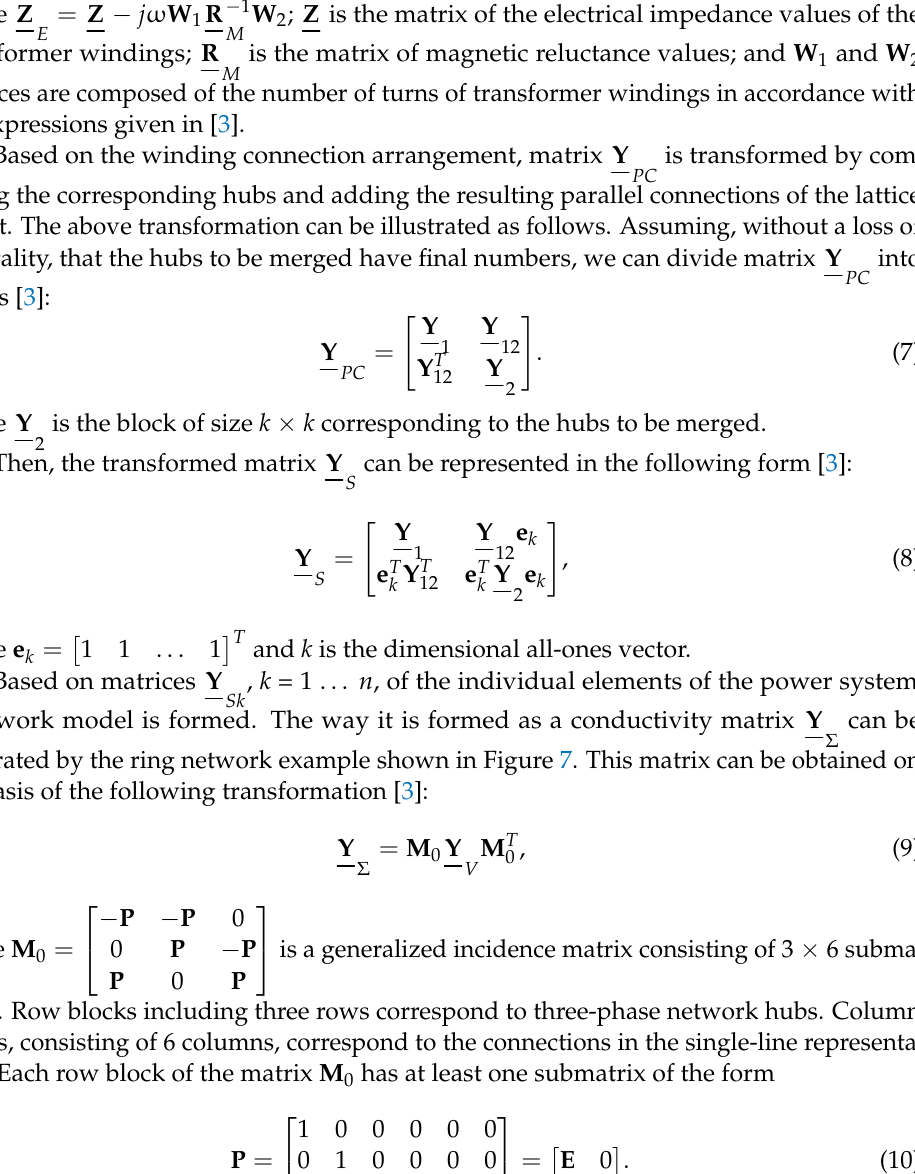
Figure 5. Original circuit of the power transmission line.